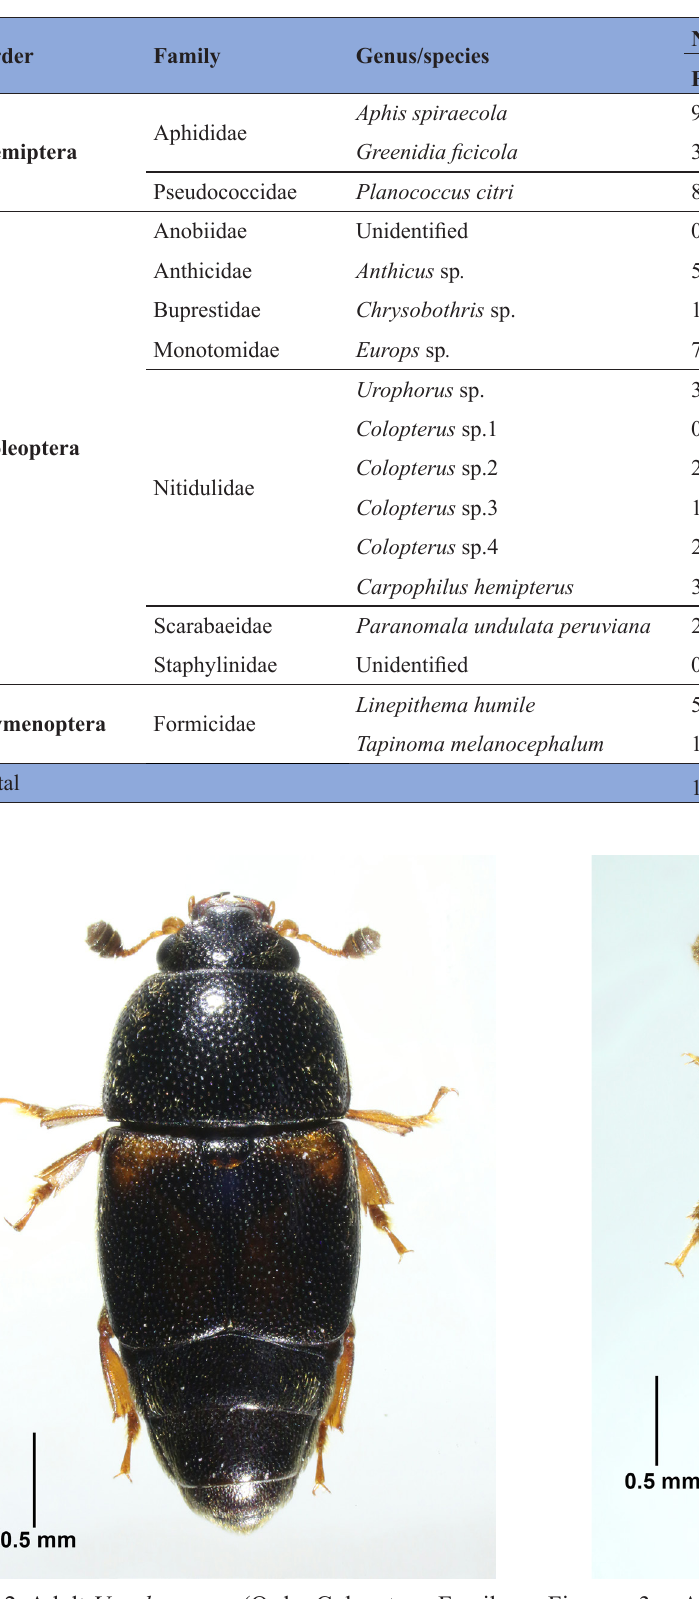
Figure 2. Adult Urophorus sp. (Order Coleoptera, Family Nitidulidae).